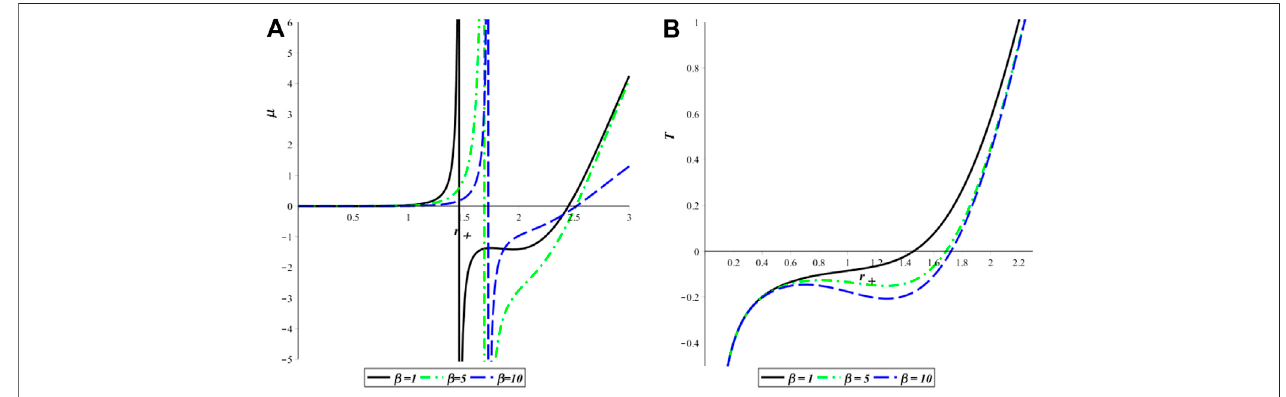
FIGURE 3 | The Joule-Thomson coef fi cient µ and temperature T of the BI quasitopological black hole with respect to r + for different values of the nonlinear parameter β with (cid:5) μ 2 (cid:1) 0 . 1, (cid:5) μ 3 (cid:1) 0 . 1, (cid:5) μ 4 (cid:1) 0 . 002, k (cid:1) 1, Q (cid:1) 2 and n (cid:1) 4 (A) Joule-Thomson coef fi cient µ , (B) Temperature T